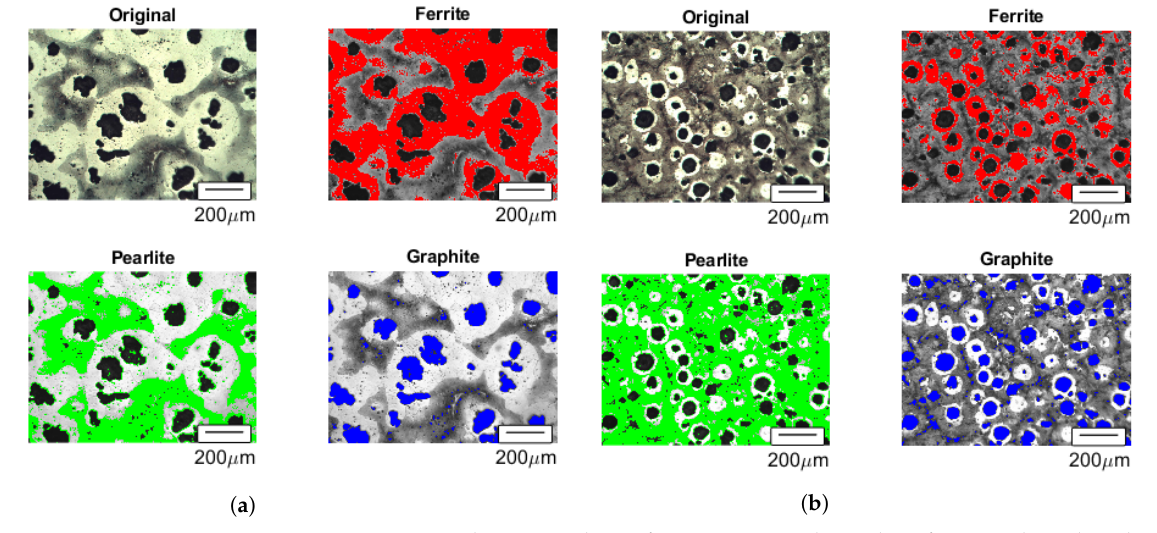
Figure 21. Computational image analysis of NCI GGG40 with graphite, ferrite and pearlite identifica- tion for round bar specimens. ( a ) Block specimens. ( b ) Round bar specimens.